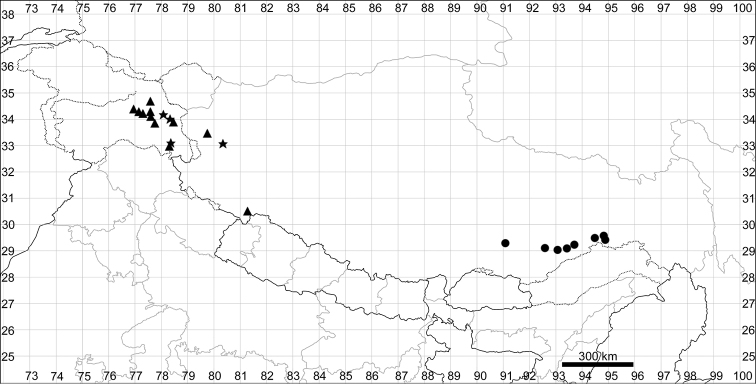
Distribution map of Corispermumlepidocarpum (circles), C.gelidum (stars) and C.tibeticum (triangles).